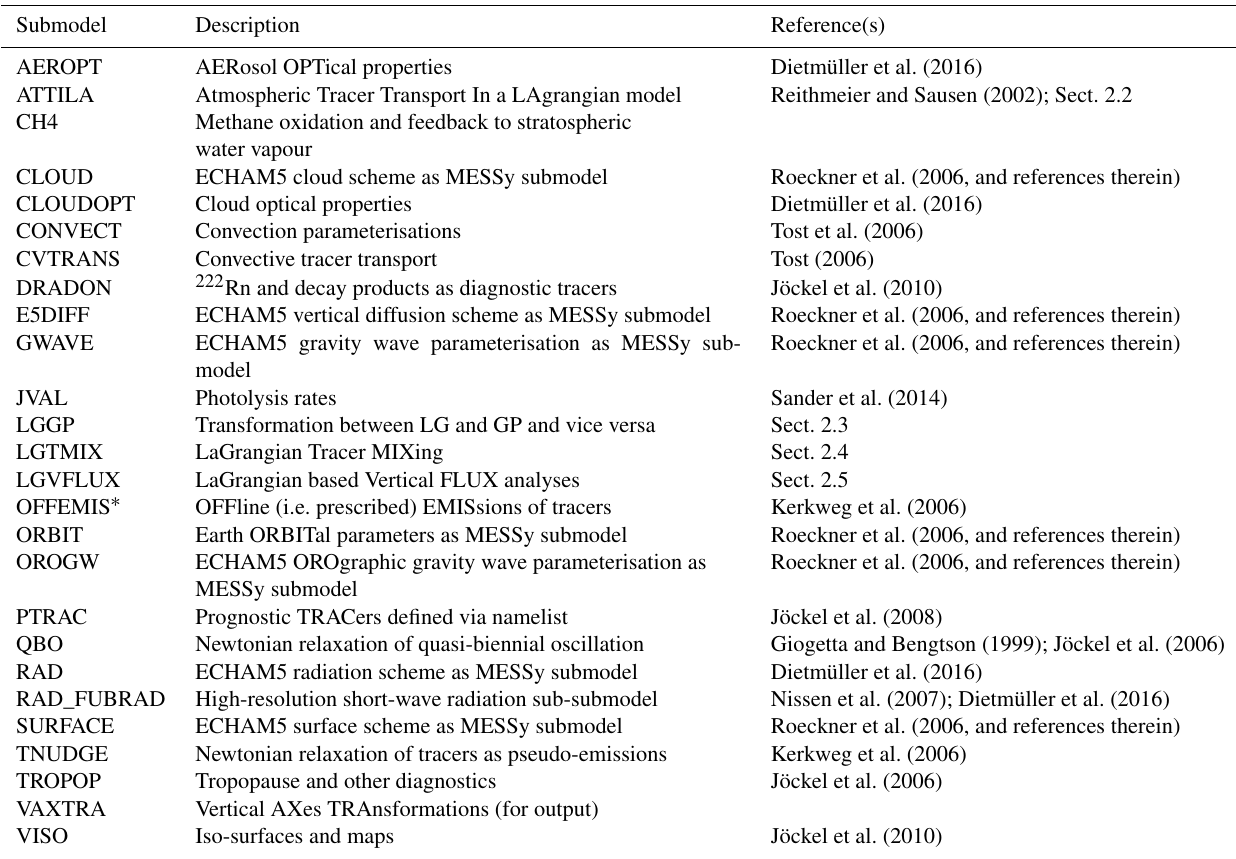
Table 1. List of MESSy submodels used for the simulations in this